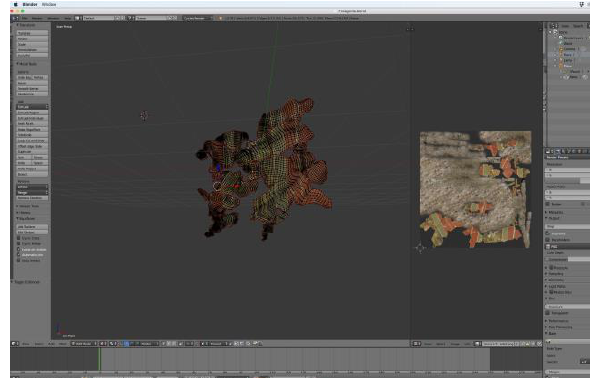
Figure 4. Retopology and texture